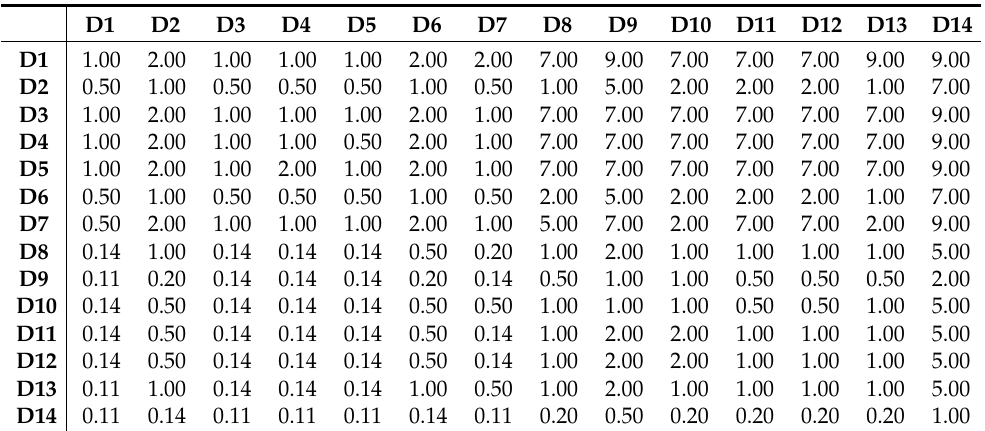
Table 13. AHP pairwise matrix to compute relative weights of the drivers for a generic structural application.